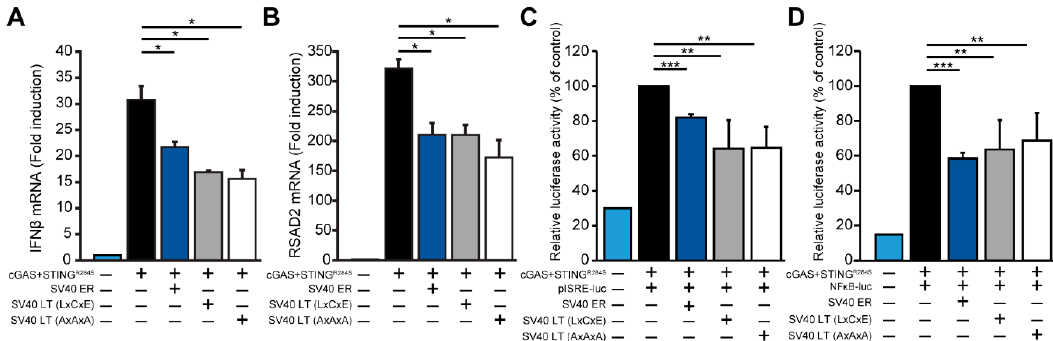
Figure 4. Antagonism of cGAS-STING dependent IFN β induction by SV40 LT. ( A ) qRT-PCR analysis of 293 cells co-transfected with 100 ng cGAS and 100 ng STING (R284S) with 800 ng of the indicated SV40 plasmid constructs (SV40 ER, LT, or LT AxAxA). Copy number for IFN β mRNA was normalized to GAPDH and calculated as fold change relative to the control untransfected cells. Error bars indicate standard deviations from three replicates. This data are representative of five independent experiments. ( B ) RSAD2 mRNA copy number from the same experiment in (A) is shown with a similar normalization to GAPDH and expressed as fold change. ( C ) Luciferase activity for pISRE and ( D ) pNF κ B reporter constructs of 293 cells co-transfected with cGAS and STING (R284S) with the indicated SV40 plasmid constructs (SV40 ER, LT, or LT AxAxA). Relative luciferase activity was normalized to levels in cGAS-STING induced control cells (first column) (Student’s t -test; *, P < 0.05; **, P < 0.01; ***, P <